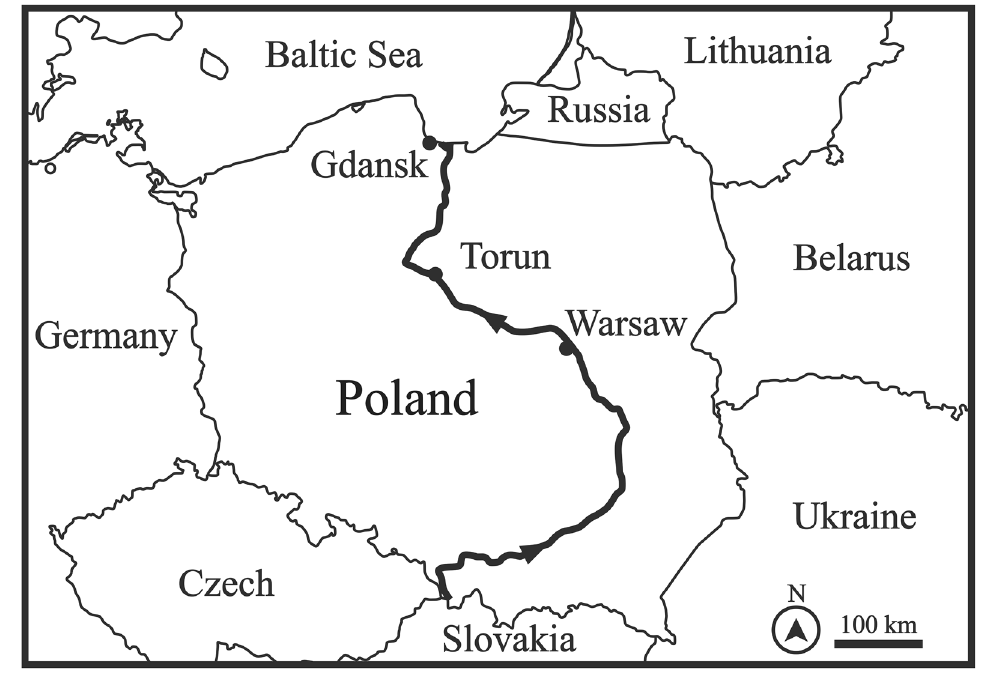
Fig. 2 The Vistula and the location of Torun station